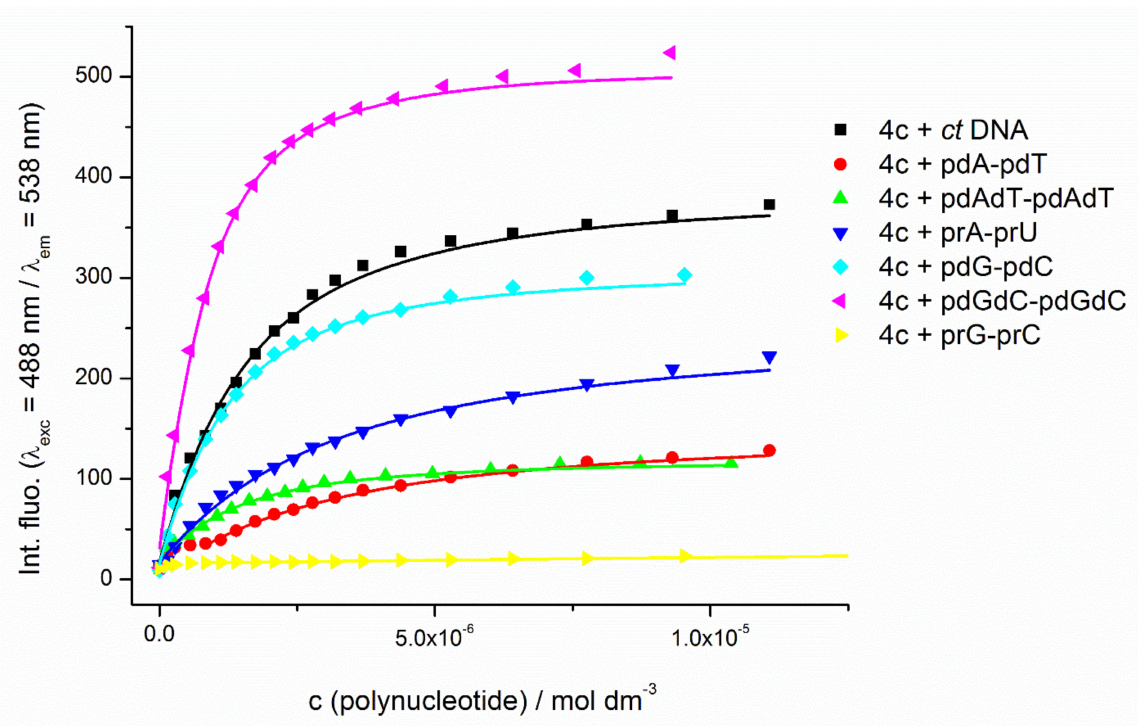
Figure 3. Changes of the fluorescence emission of 4c (c = 1.48 × 10 − 7 mol dm − 3 ) upon addition of ds -polynucleotides at pH 7 (Na-cacodylate buffer, pH = 7.0, I =0.05 M; λ exc = 488 nm/ λ em = 538 nm; excitation slit of 5 nm and emission slit of 10